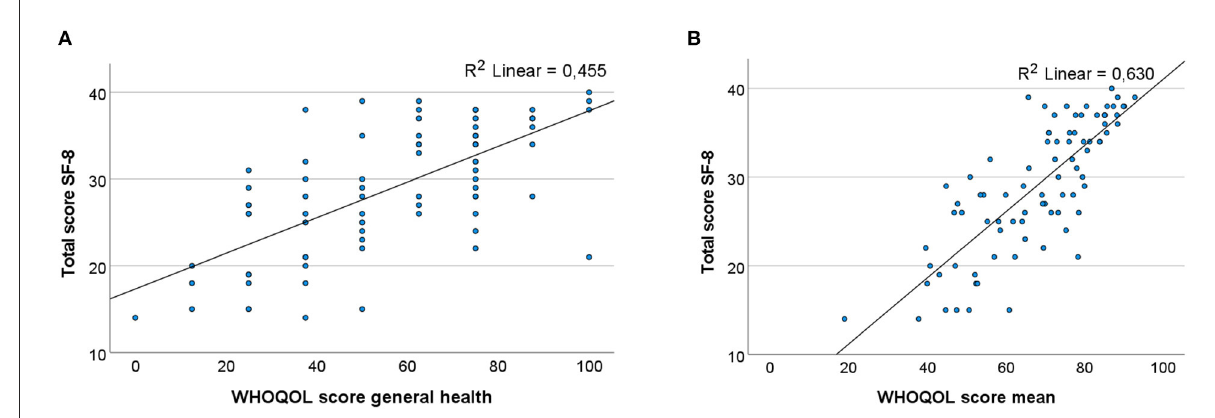
FIGURE2 (A) Scatterplot of the correlation between WHOQOL-BREF general health and the total score of the SF-8 ( r = 0.675, p < 0.001). (B) Scatterplot of the correlation between the WHOQOL-BREF mean score and the SF-8 total score ( r = 0.794, p < 0.001).